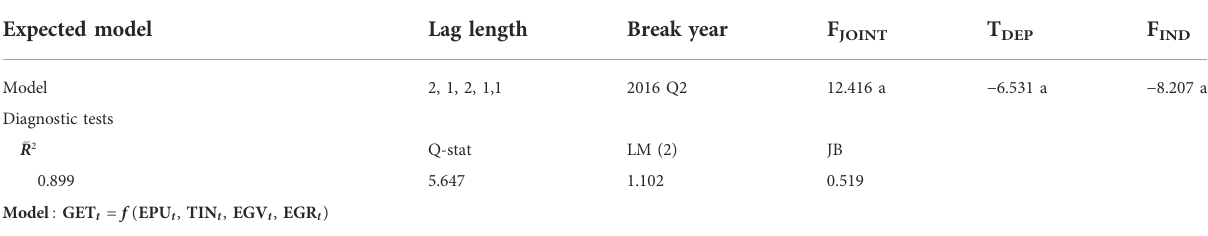
TABLE 4 Bootstrapped ARDL cointegration